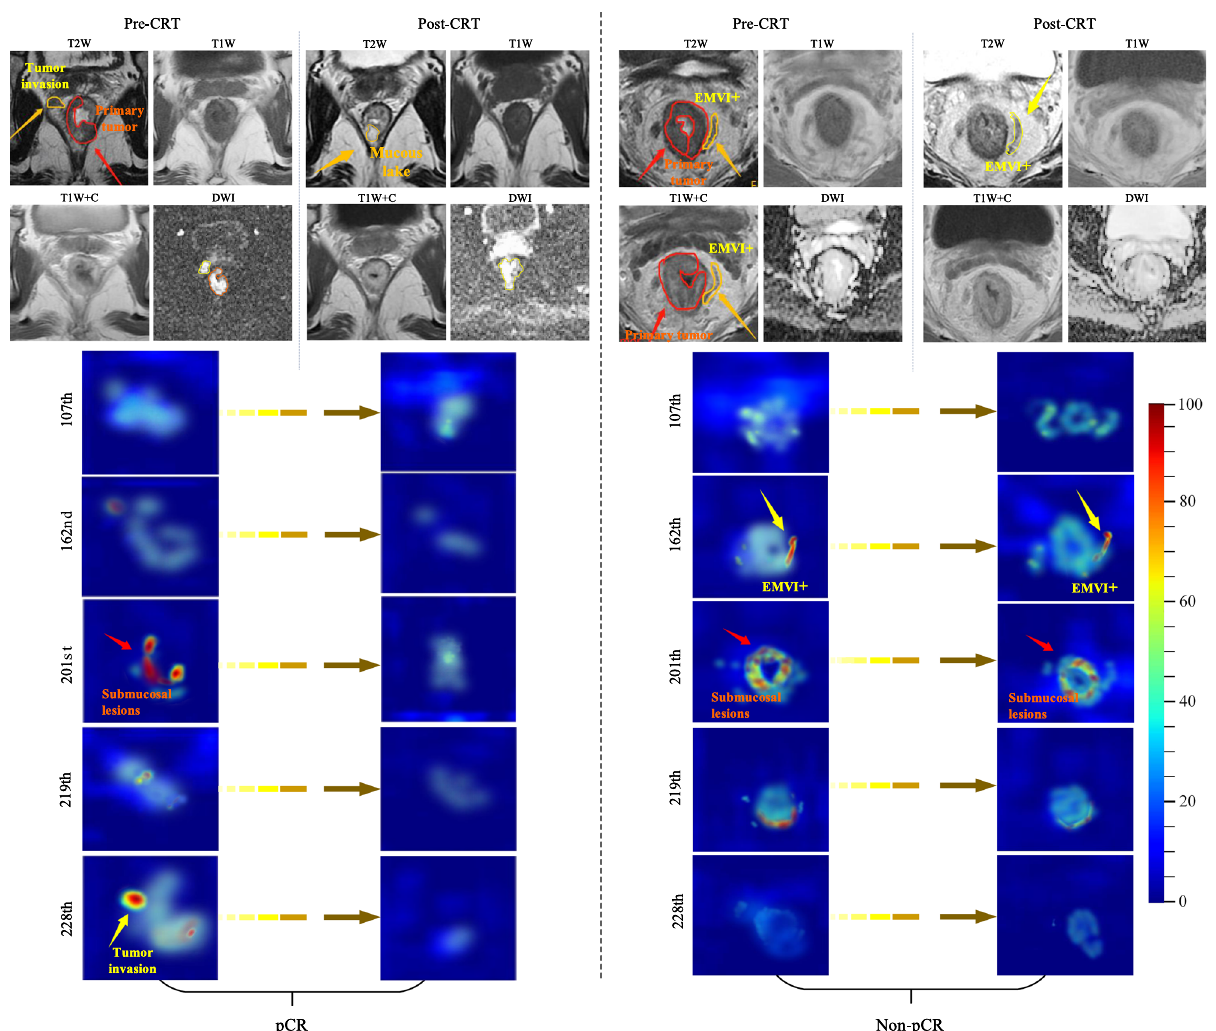
Fig. 4 Network visualization and interpretation. Pre- and post-therapy MRI and the corresponding feature map visualization in key channels at the bottom of 3D RP-Net for two representative patients who were correctly predicted to be pCR and non-pCR, respectively. In the 107th channel corresponding to positive lymph nodes, there was no activation (maximum magnitude <50%) in either case. In the 162nd channel corresponding to EMVI, feature map was not activated in the case with pCR, while the overall magnitude decreased by only 9.2% ( p = 0.89) with non-pCR. In the 201st channel corresponding to submucosal lesions, the overall magnitude of the feature map decreased by 88.9% ( p < 0.001) with pCR, but decreased by only 11.3% ( p = 0.67) with non- pCR. In the 219th channel corresponding to mesorectum invasion, the overall magnitude of the feature map decreased by 85.7% ( p < 0.001) with pCR, but decreased by only 16.7% ( p = 0.41) with non-pCR. In the 228th channel corresponding to tumor invasion, the overall magnitude of the feature map decreased by 90.5% ( p < 0.001) with pCR, while tumor invasion was not activated with non-pCR. p values were computed based on the two-sided paired t test between the corresponding feature maps within each channel ( n = 256 feature values) and adjusted for multiple comparisons. CRT, chemoradiotherapy; pCR, pathologic complete response; EMVI, extramural vascular